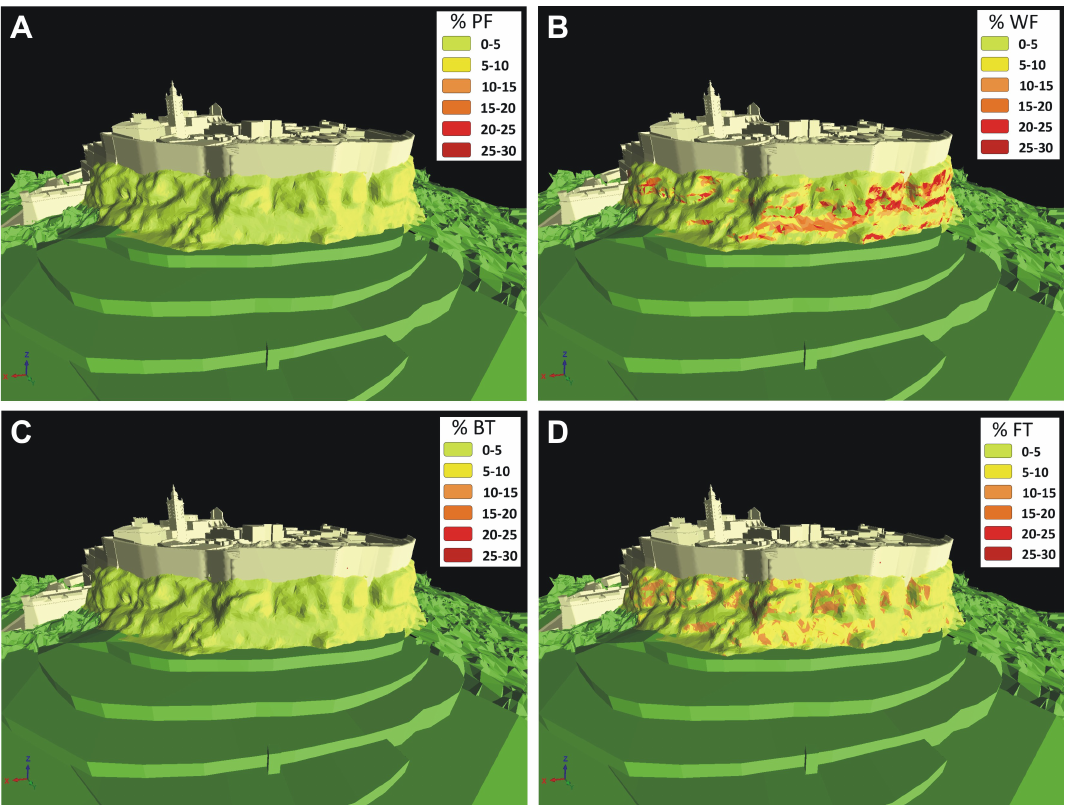
Fig. 13. 3-D maps derived from the results of the kinematic analysis for the northern sector of Citadel rock mass. (A) : Plane failure (PF); (B) : wedge failure (WF); (C) : block toppling (BT); (D) : flexural toppling (FT).